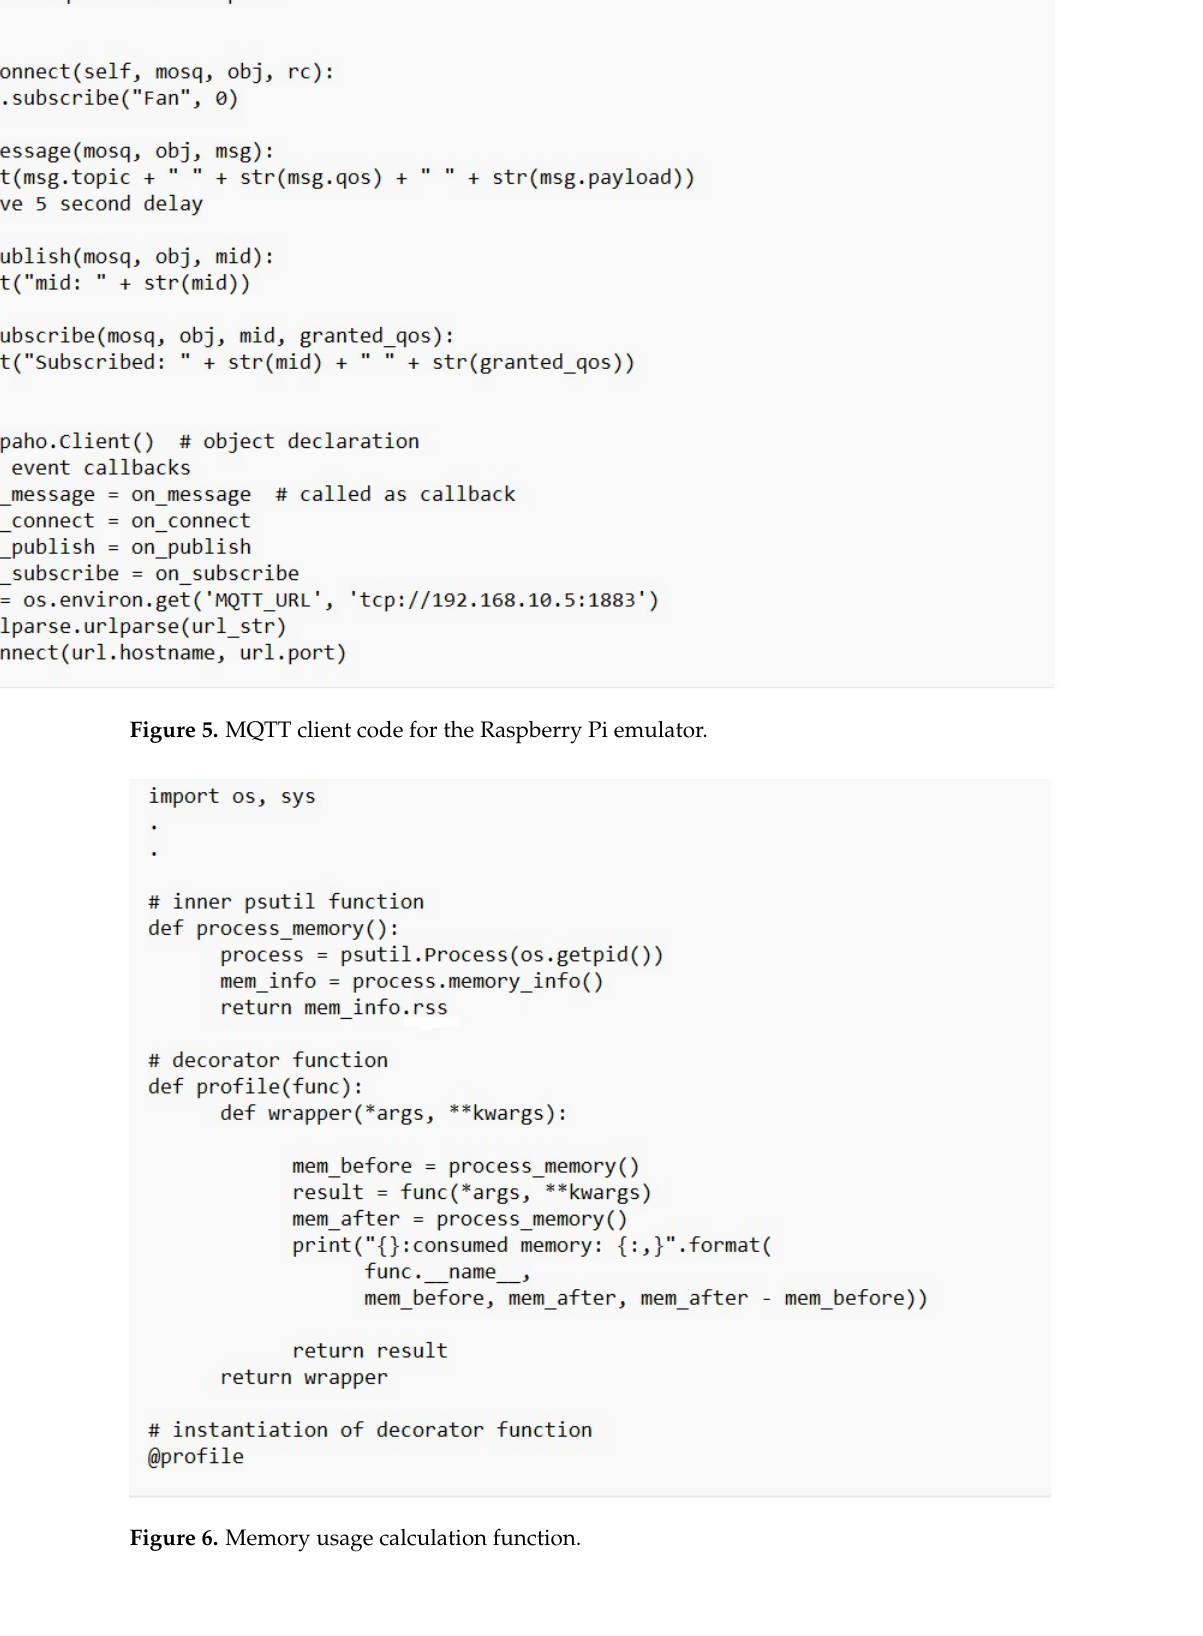
Figure 6. Memory usage calculation